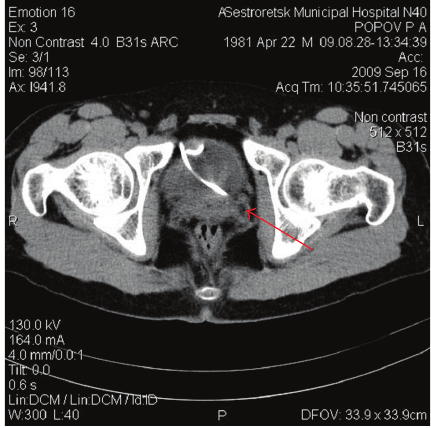
Figure 5: CT showing no stone in the ureter; the area of previous stone location is shown by red